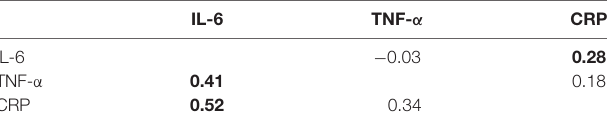
TABLE 2 | Bivariate correlations among the three inflammations markers in young and older